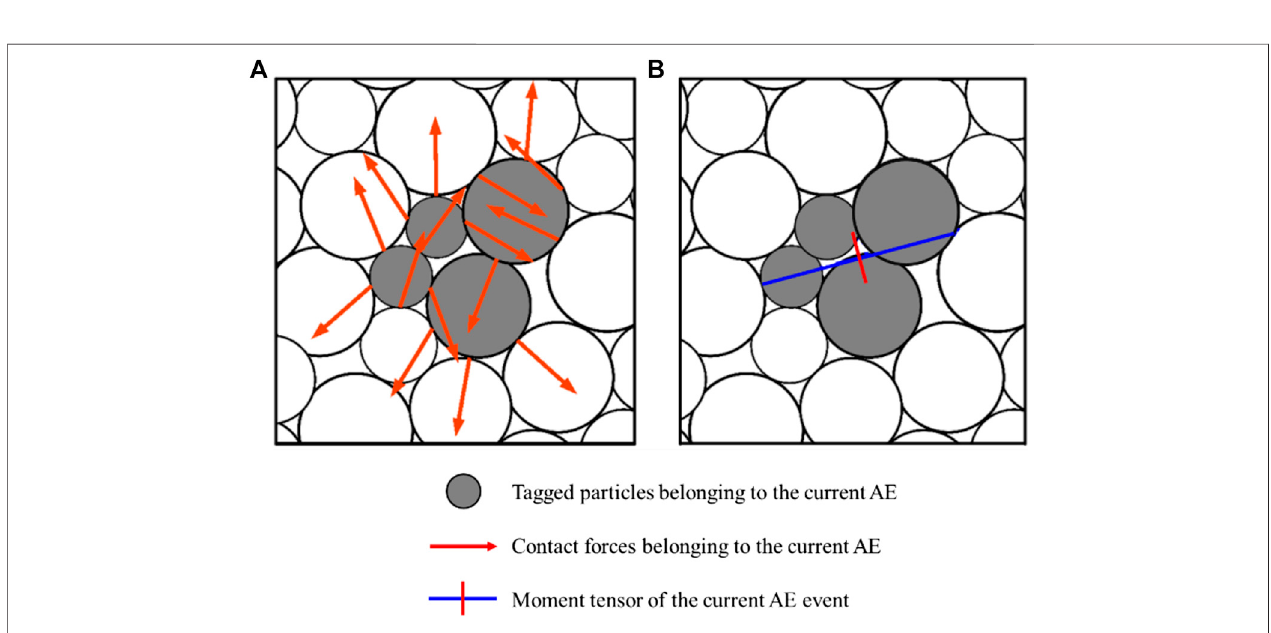
FIGURE7| TheexampleofanAEeventanditscalculationmomenttensor. (A) ThecontactforceofallparticlesinanAEevent. (B) Thecalculatedmomenttensorof this event. The length of these two lines represent the principal values of the moment tensor. The red line represents tensile and the blue line represents compression.